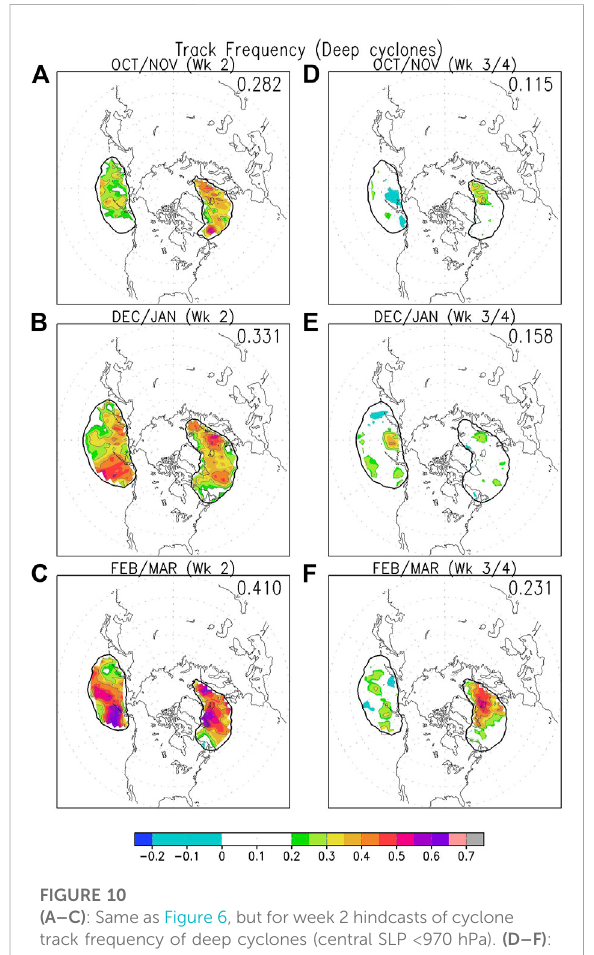
FIGURE 10 (A – C) : Same as Figure 6, but for week 2 hindcasts of cyclone track frequency of deep cyclones (central SLP < 970 hPa). (D – F) : Same as (A – C) , but for weeks 3-4 hindcasts of cyclone track frequency of deep cyclones.